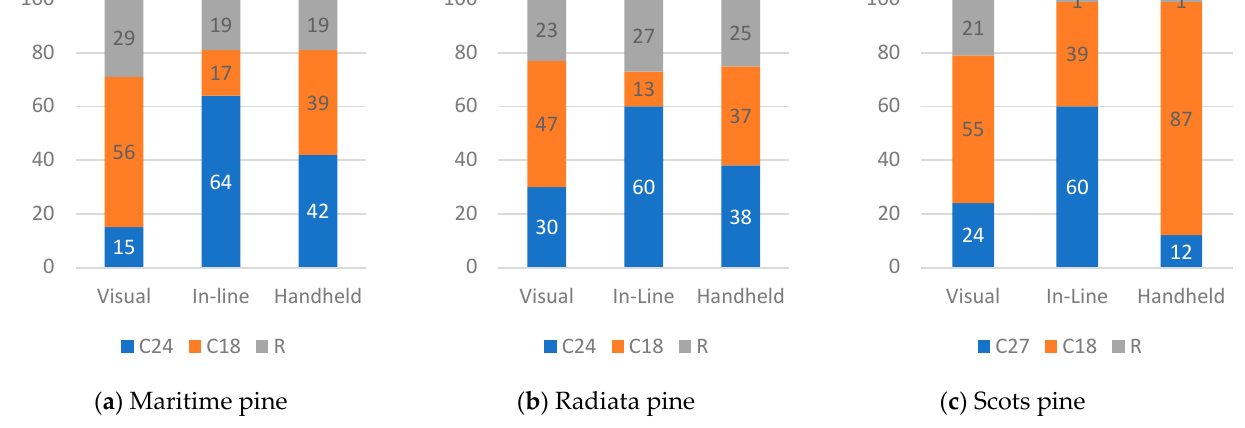
Figure 8. Yields (%) comparison between visual and machine grading for C classes.